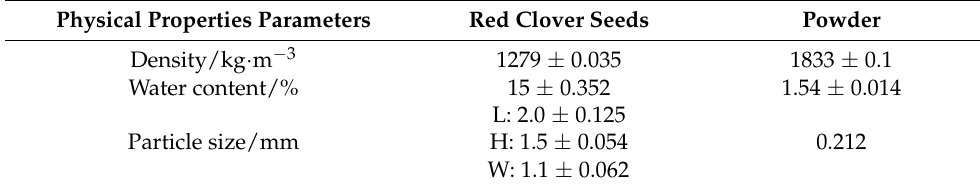
Table 1. Basic physical properties of coated powder. Physical Properties Parameters Red Clover Seeds